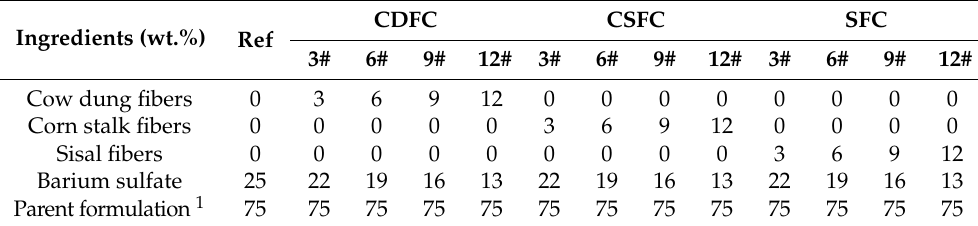
Table 1. The composition of the prepared polymer